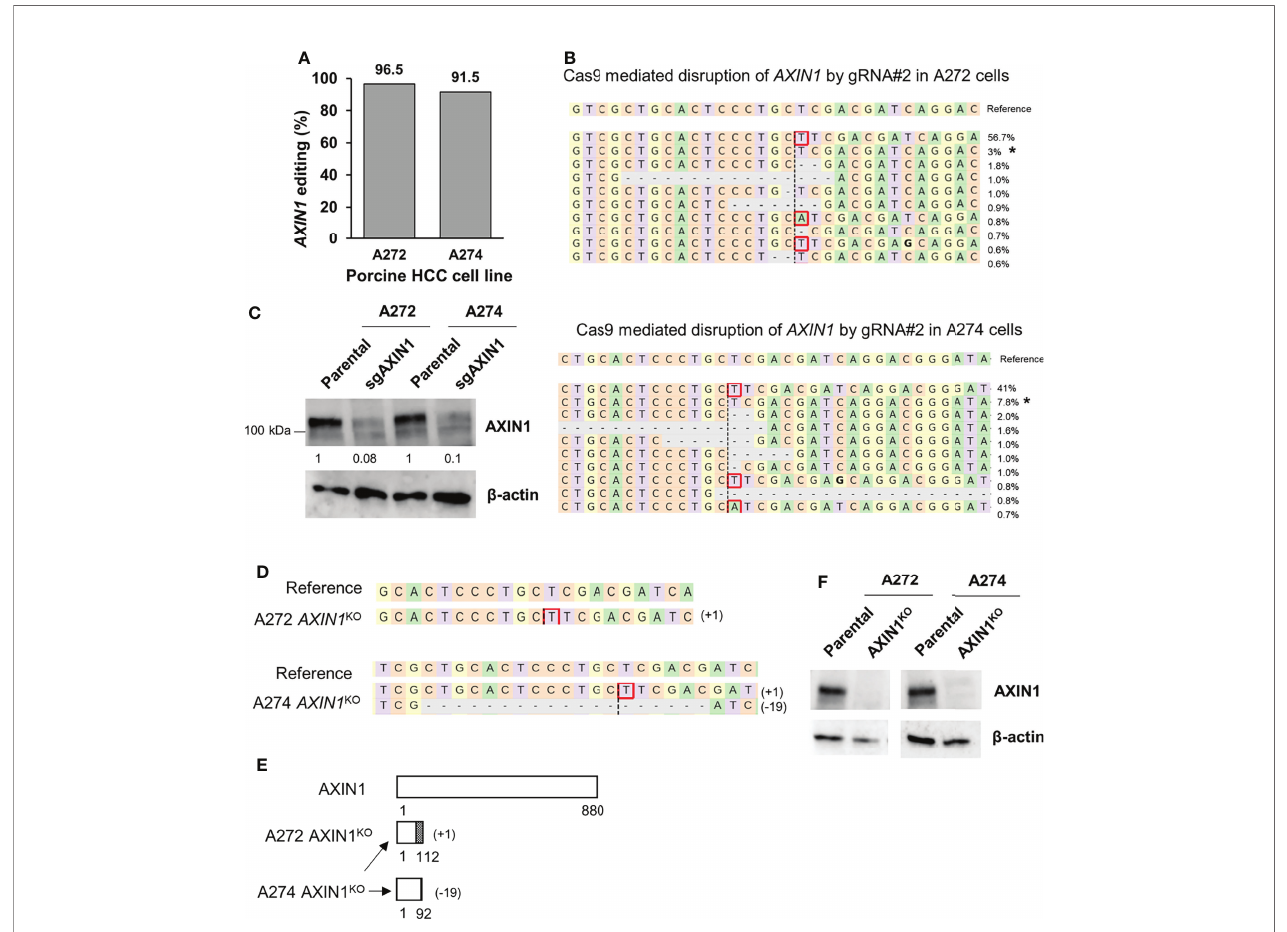
FIGURE 2 | Generation of AXIN1 KO porcine HCC cells by CRISPR/Cas9. (A) CRISPR/Cas9-induced editing of AXIN1 in A272 and A274 porcine HCC cells using AXIN1 gRNA#2. Genomic DNA was collected two days post-transfection and analyzed by targeted NGS. The bar graph depicts the percentages (%) of total reads that displayed indels at the gRNA target site. (B) Top 10 reads detected by targeted NGS analysis in the two porcine HCC lines mapped to the reference sequence. The percentage of reads of each sequence are shown on the right. The asterisk (*) indicates/marks non-edited reads. Dashed line, predicted Cas9 cleavage position; red box, insertion; dash, deleted base. (C) Con fi rmation of AXIN1 protein depletion by Western blotting in A272 and A274 porcine HCC cell pools transfected with Cas9 and gRNA#2. The cells were lysed two days post-transfection and analyzed by Western blotting using an anti-AXIN1 antibody. b -actin was used as a loading control. (D – F) Analysis of AXIN1 KO single cell clones isolated from A272 and A274 porcine HCC cells transfected with Cas9 and AXIN1 gRNA#2. (D) Reads detected by targeted NGS analysis mapped to the reference sequence (top) for A272 and A274 AXIN1 KO cells. Dashed line, predicted Cas9 cleavage position; red box, insertion; dash, deleted base. (E) Schematic representation of predicted translation of AXIN1 protein in the isolated AXIN1 KO HCC cells. The dotted region represents amino acids with frameshift mutation. (F) Con fi rmation of complete loss of AXIN1 protein in A272 AXIN1 KO and A274 AXIN1 KO cells by Western